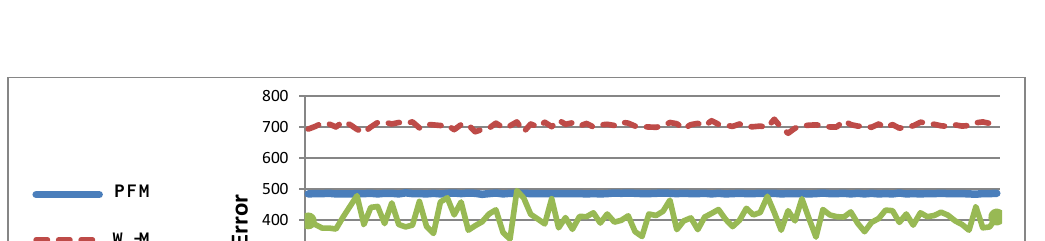
Figure 8. Error in Geyser.